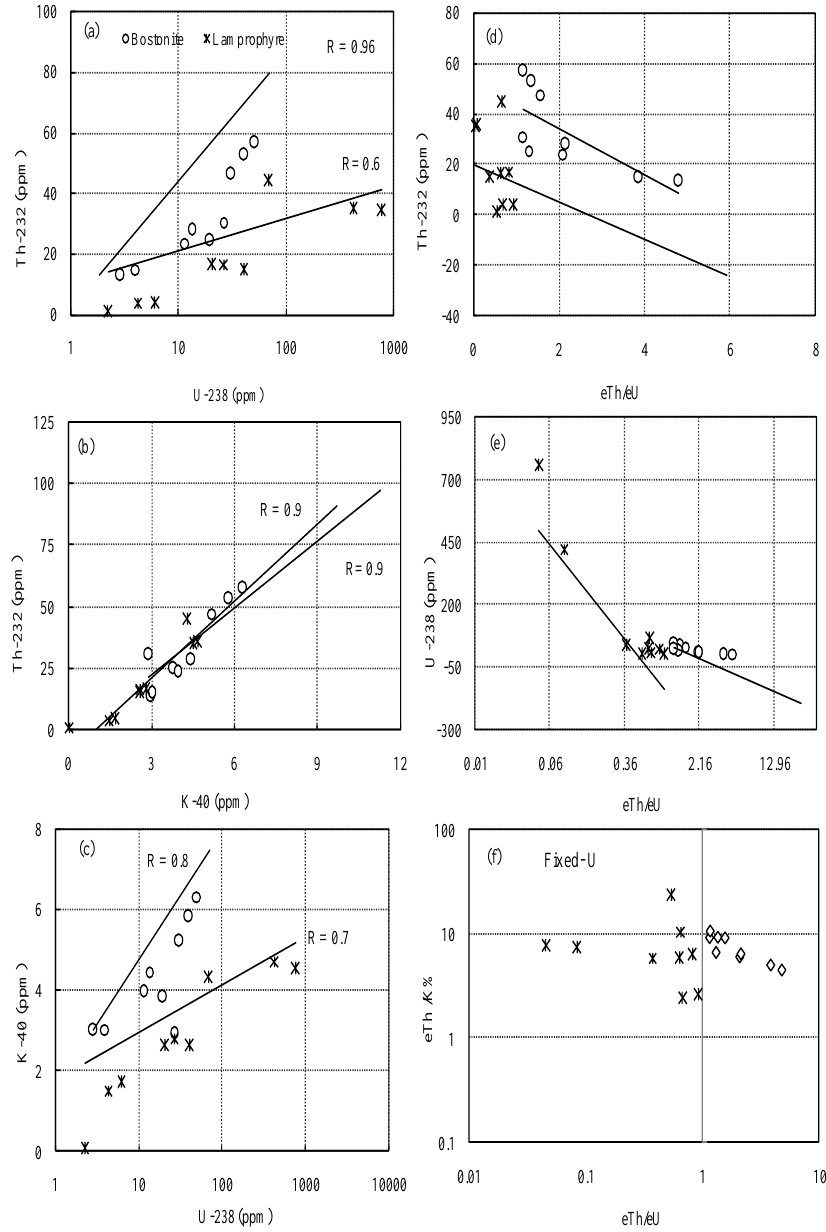
Figure 8. ( a ) Th vs. U, ( b ) Th vs. K, ( c ) K vs. U, ( d ) eTh vs. eTh/eU, ( e ) eU vs. eTh/eU, and ( f ) eTh/K% vs. eTh/eU for bostonite and lamprophyre granites of the Sol Hamed area. Positive correlations between Th and U were observed for coarse-grained granite, fine-grained granite, bostonite, and lamprophyre (R = 0.7, 0.6, 0.9, and 0.6, respectively), suggesting magmatic processes exerted a significant influence on radioelement concentra- tion (Figures 7a and 8a).